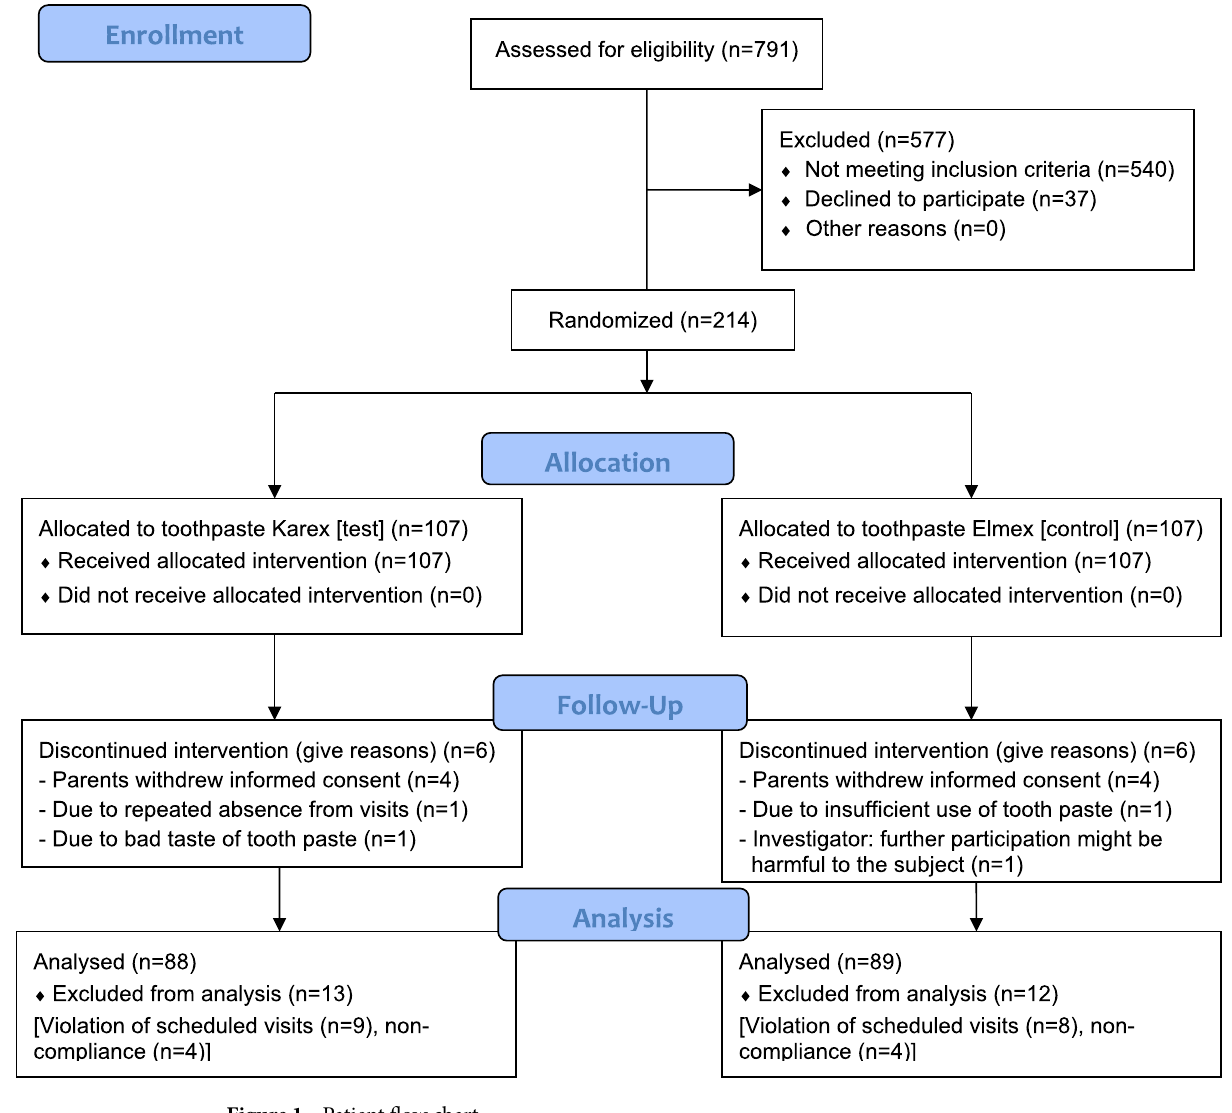
Figure 1. Patient flow chart.